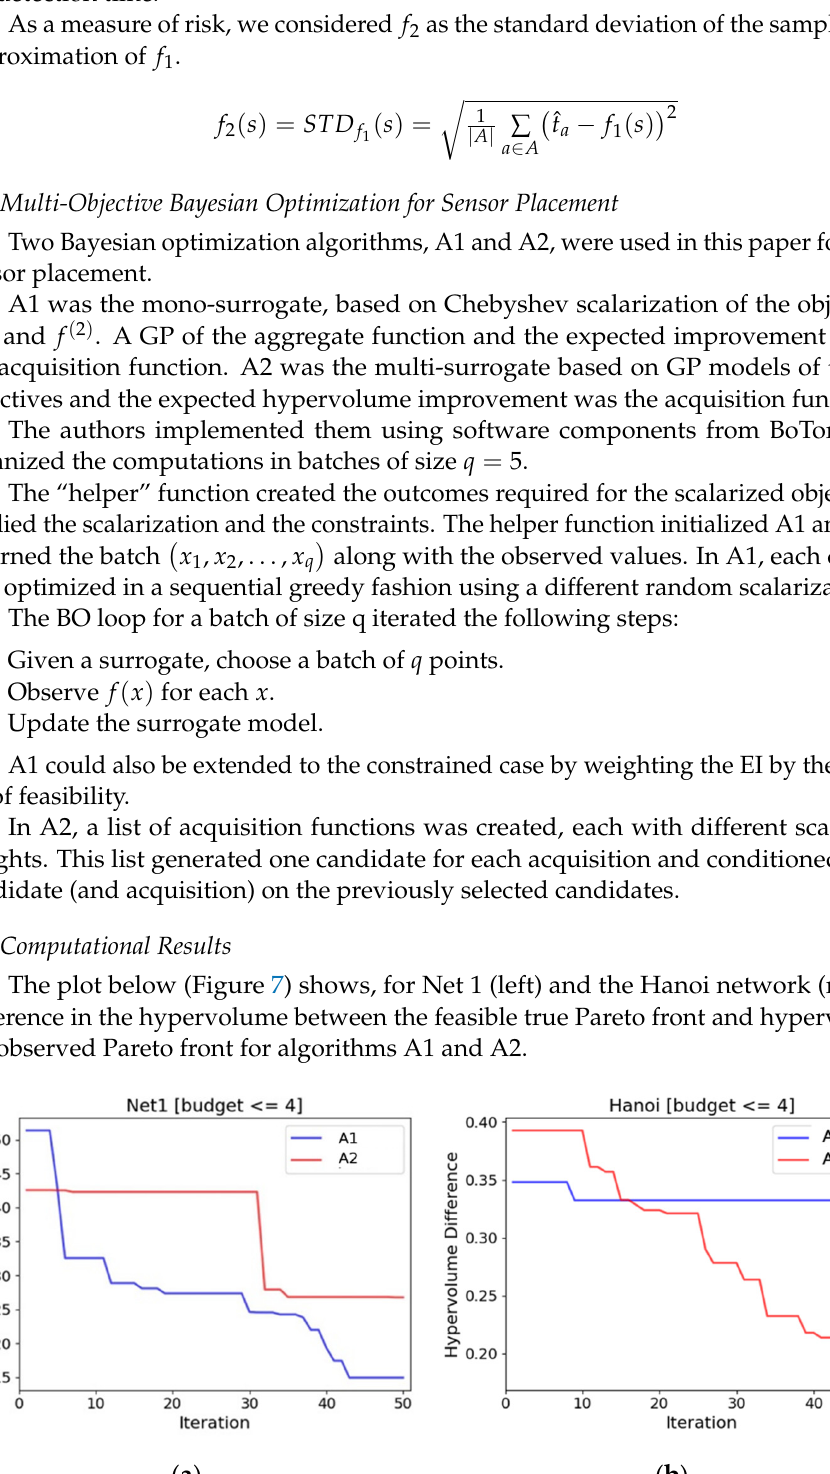
( b ) Figure 8. The objective space considering Hanoi network using algorithm A1 ( a ) and A2 ( b ). True Pareto front in red. Lighter colors denote later iterations. An example of the sensor placement given by the algorithms is reported in Figures 9 and 10.